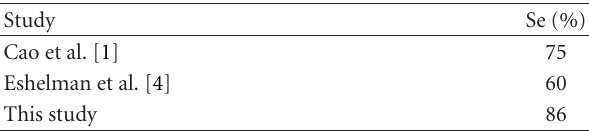
Table 8: Comparison of several classifier performances on MIMIC II ICU database (blank boxes have not been